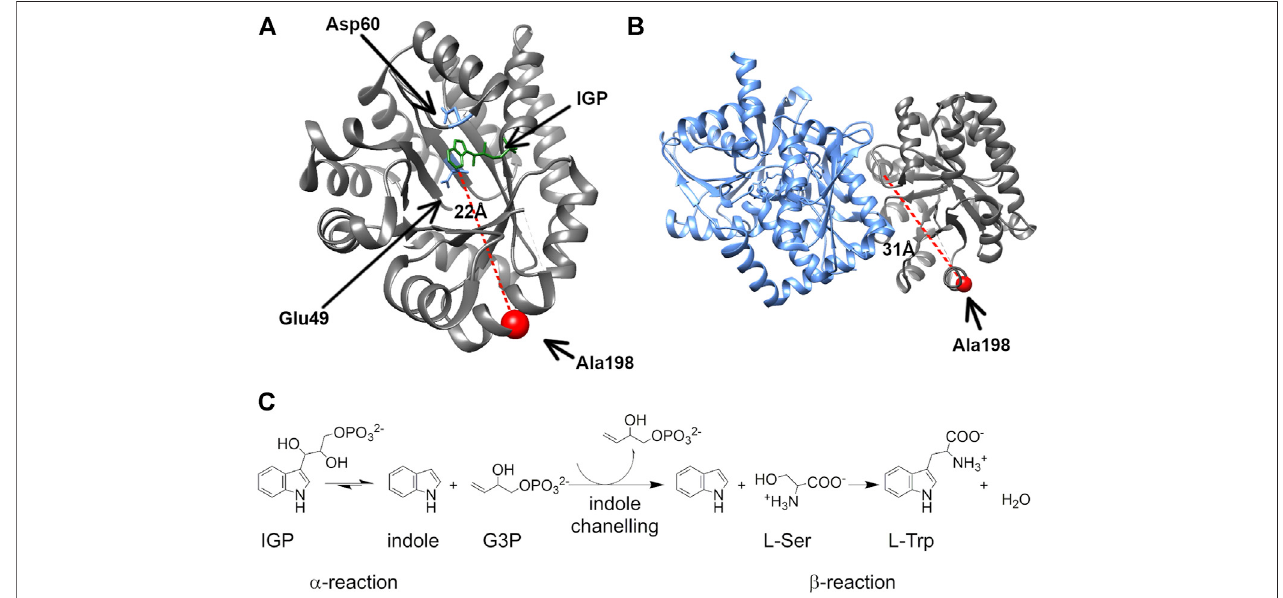
FIGURE 1 | The surface-exposed, network residue Ala198 is remote from both the α TS active site and the α TS- β TS interface. Structures of (A) the α TS subunit (PDBIDCode:2RH9),highlightingcatalyticresiduesGlu49andAsp60,thesubstrateIGP,andAla198,and (B) thefulltryptophansynthasecomplexwiththe β TSsubunit pictured in blue (C) Reactions catalyzed by alpha and beta subunits of